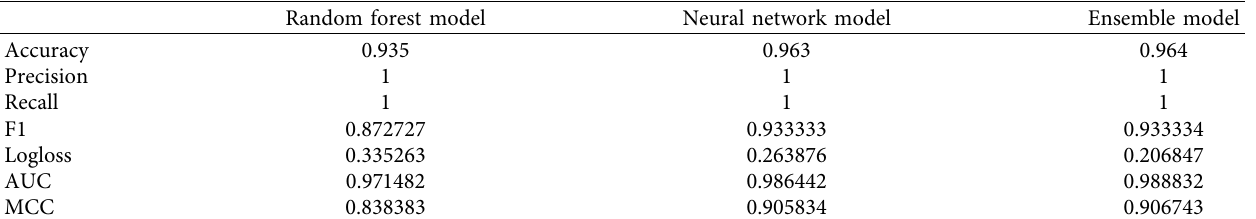
Figure 2: Predictive ensemble model generation using random forest and neural network models. Table 2: Evaluation metrics for the random forest, neural network, and ensemble